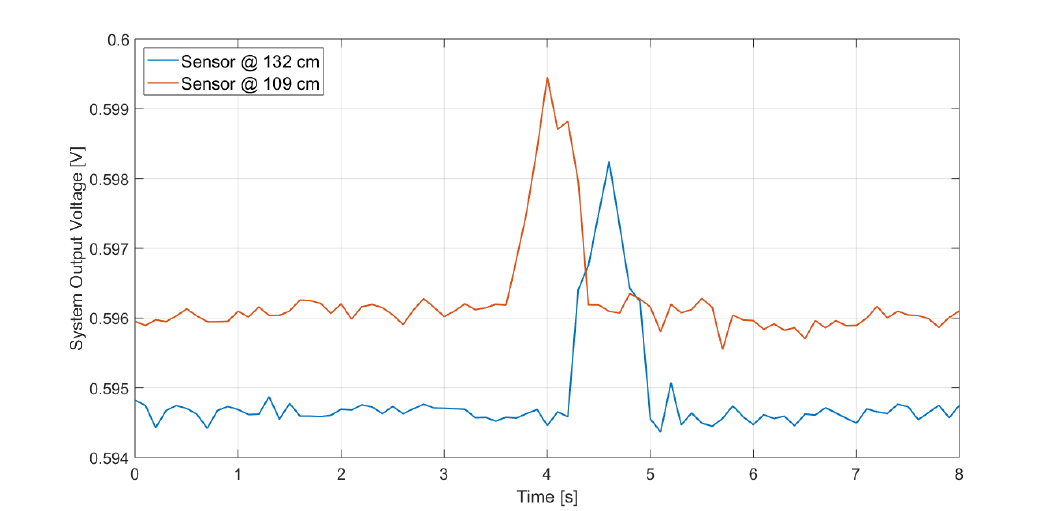
Figure 22. Measurements results in the case of a subject running at 2.5 m in front of the sensor, for different sensor